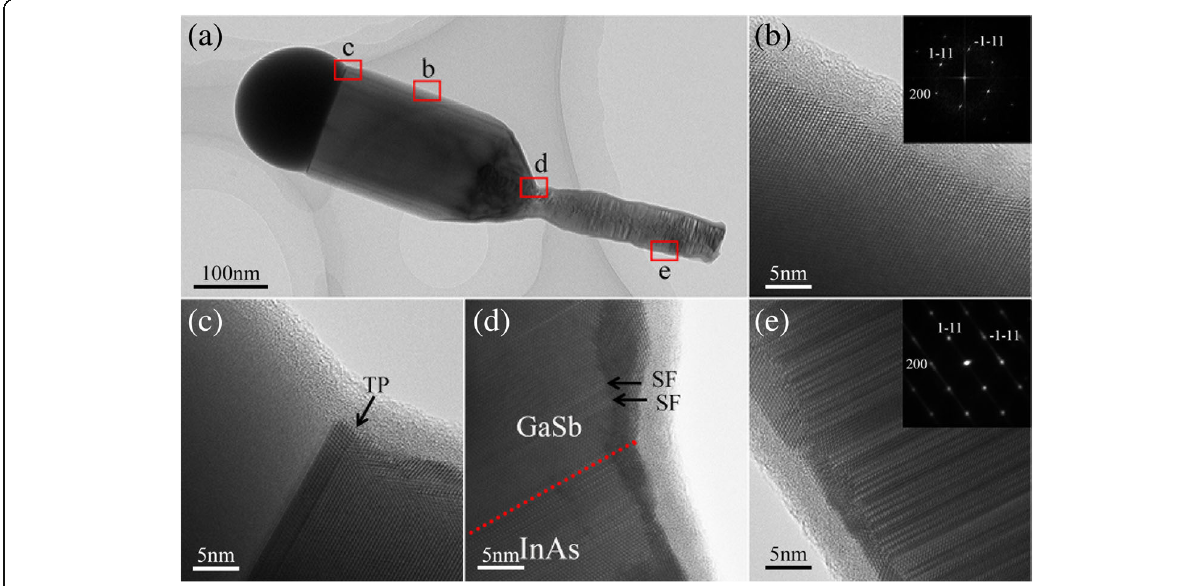
Fig. 5 a A low-magnification TEM image of a typical InAs/GaSb heterostructure nanowire. b – e High-resolution TEM (HRTEM) images taken from the regions marked with red rectangles in ( a ) respectively. All HRTEM images are acquired from the 〈 110 〉 zone axis. The red dashed line in d indicates the interface between the InAs stem and the upper GaSb nanowire. The insets in b and e are the corresponding fast Fourier transform (FFT) patterns of the GaSb nanowire and the InAs stem,